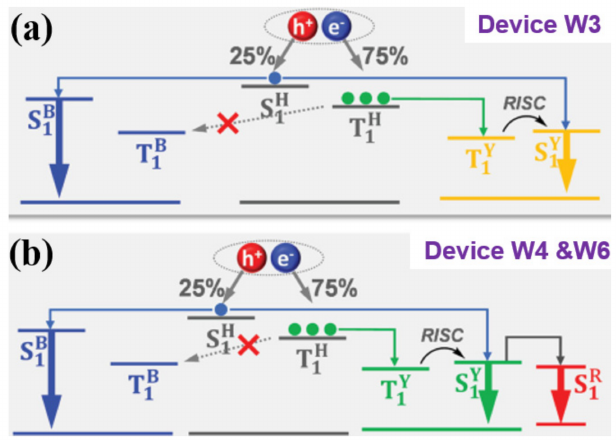
Figure 5. Device function mechanisms of the conceptual utilization of singlet and triplet excitons generated in EMLs. ( a ) device W3; and ( b ) devices W4 and W6. H, B, Y and R are CBP, NI-1-PhTPA, PXZDSO2 and DBP, respectively. Reproduced with permission from [56], John Wiley and Sons, 2016.